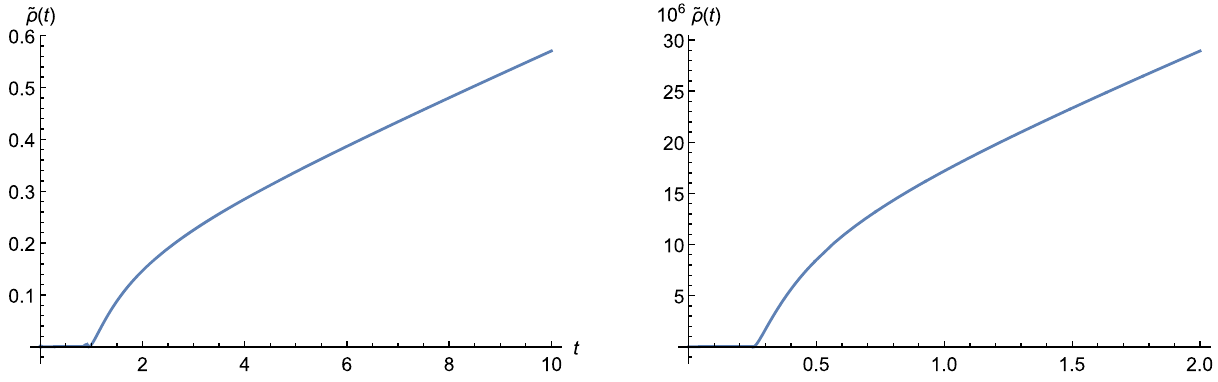
Fig. 13 Spectral function for the propagator (cid:2) A a μ ( p ) A b ν ( − p ) (cid:3) in the unitary gauge, with t given in unity of μ 2 , for the Region I (left) and Region II (right), with parameter values given in Table 1